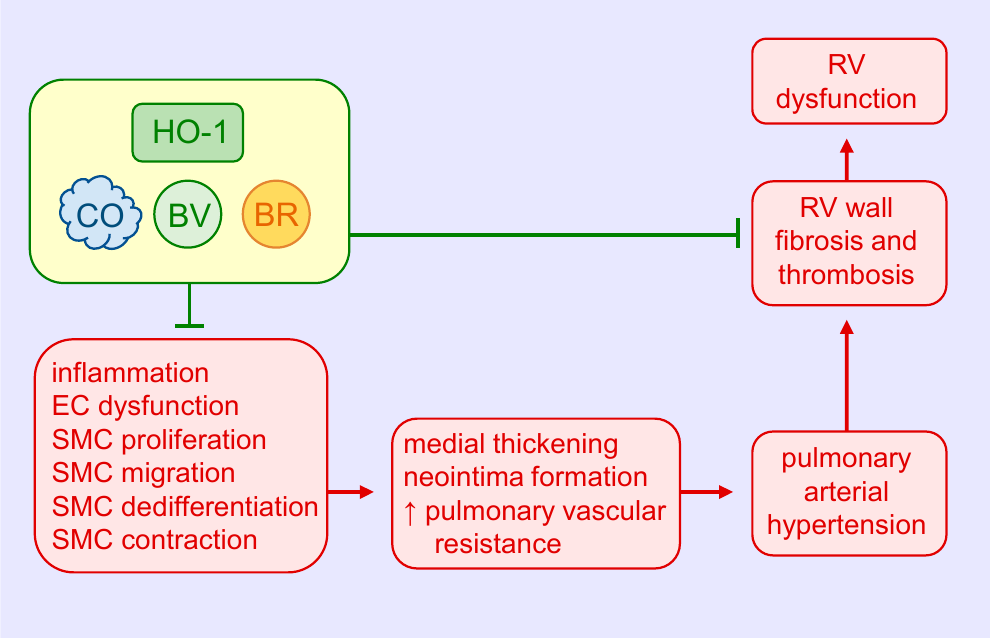
Figure 4. Heme oxygenase-1 (HO-1) inhibits pulmonary arterial remodeling, pulmonary vascular resistance, and right ventricular (RV) dysfunction in pulmonary arterial hypertension. HO-1-derived carbon monoxide (CO) and the bile pigments, biliverdin (BV) and bilirubin (BR), block medial and intimal thickening and pulmonary vascular resistance by attenuating pulmonary inflammation, endothelial cell (EC) dysfunction, and vascular smooth muscle cell (SMC) proliferation, migration, dedifferentiation, and contraction. HO-1 and its products also prevent the dysfunction of the RV in pulmonary arterial hypertension by inhibiting ventricular wall fibrosis and thrombosis.